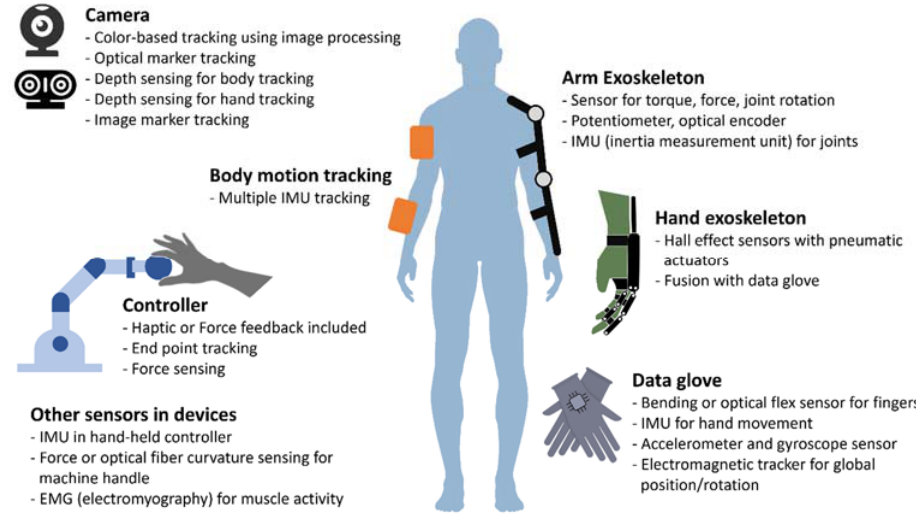
Figure 2. Classification of sensor types used in virtual rehabilitation for upper limb rehabilitation.